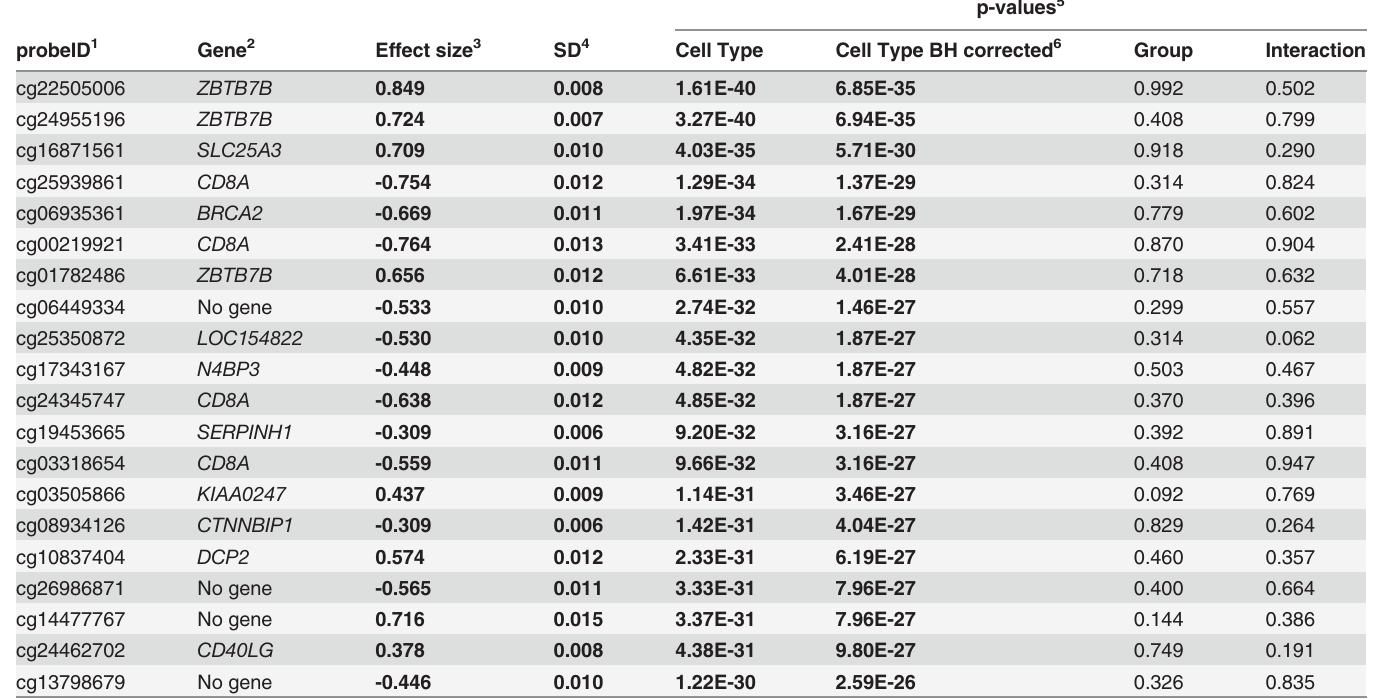
Table 5. Distinct differences between CD4+ and CD8+ T-cells observed in the ‘ cell type ’ term when applying a linear regression two-way interaction model including both the CD4+ and CD8+ T cell methylation data, including the terms ‘ cell type ’ , ‘ group ’ (case-control status), and ‘ interaction ’ (case-control status x cell